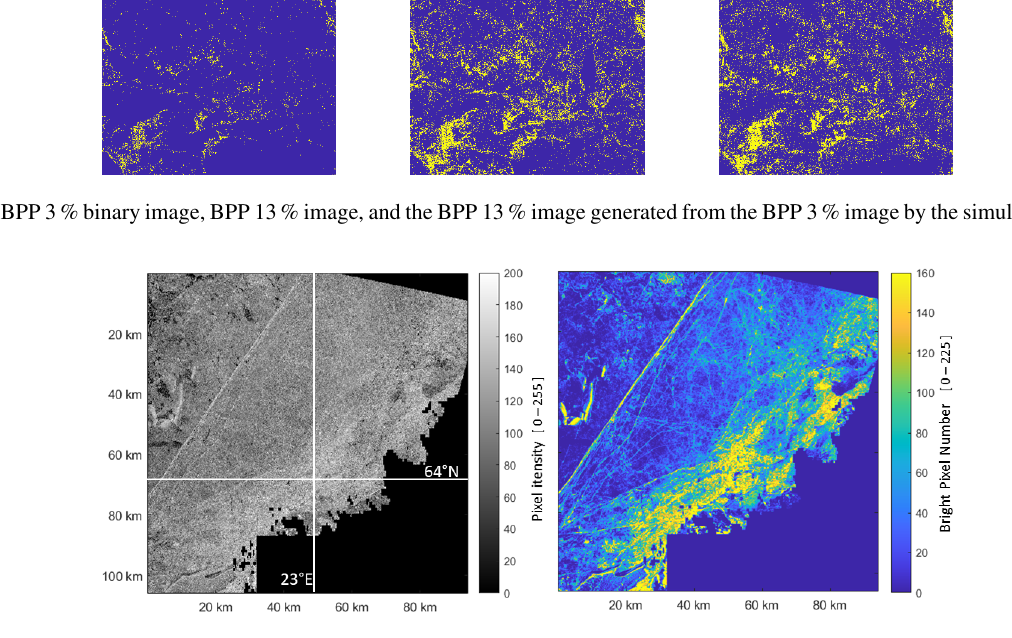
Figure 11. The test area covered by the TSX SAR imagery with resolution of 20m. On the right is the contextual image with BPP